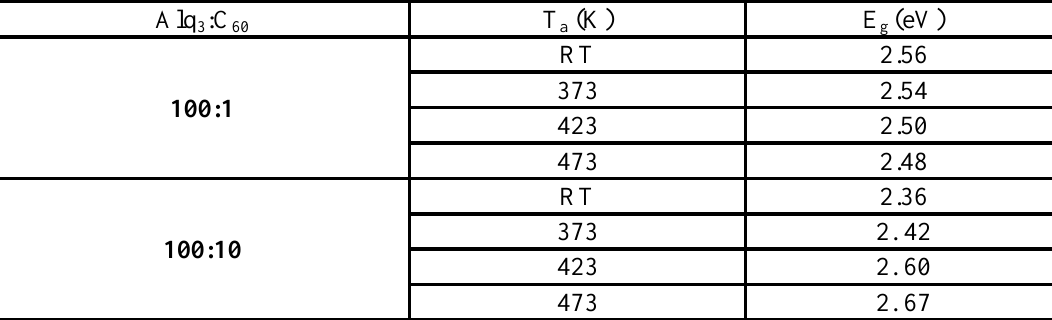
:C thin films. 3 60